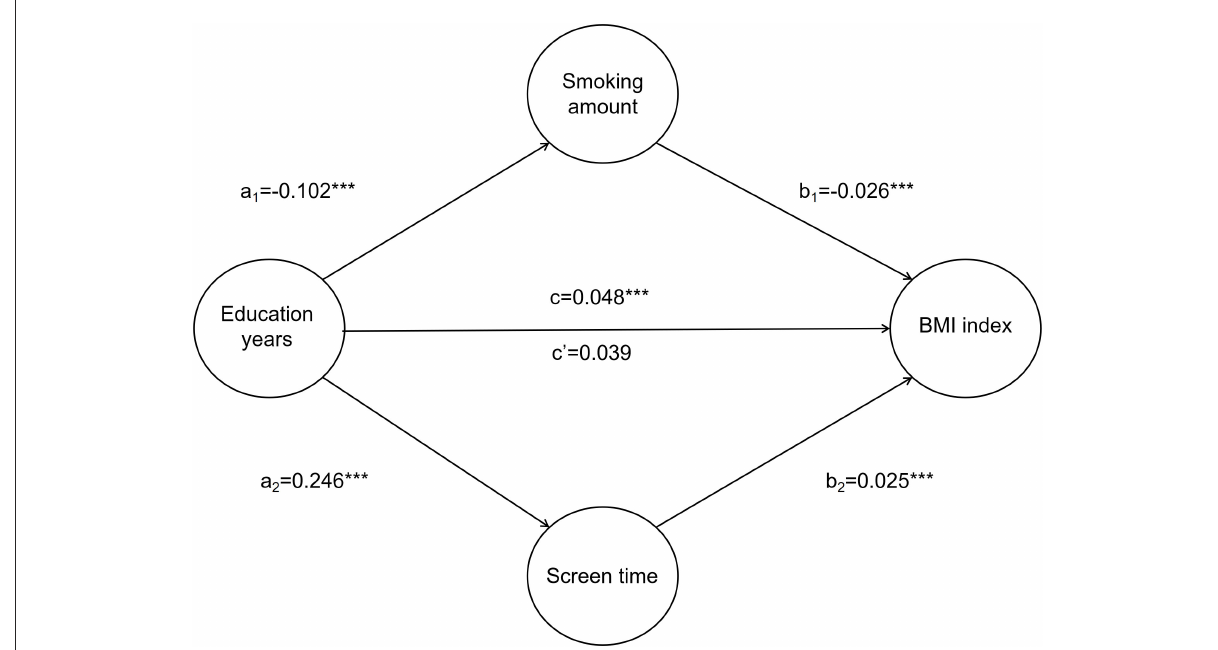
FIGURE1 Mediating effect of smoking amount and screen time on education years and BMI. a 1 represents the effect value of education years on smoking amount; a 2 represents the effect value of education years on screen time; b 1 represents the effect value of smoking amount on BMI index; b 2 represents the effect value of screen time on BMI index; c represents the total effect value of education years on BMI index; c’ represents the